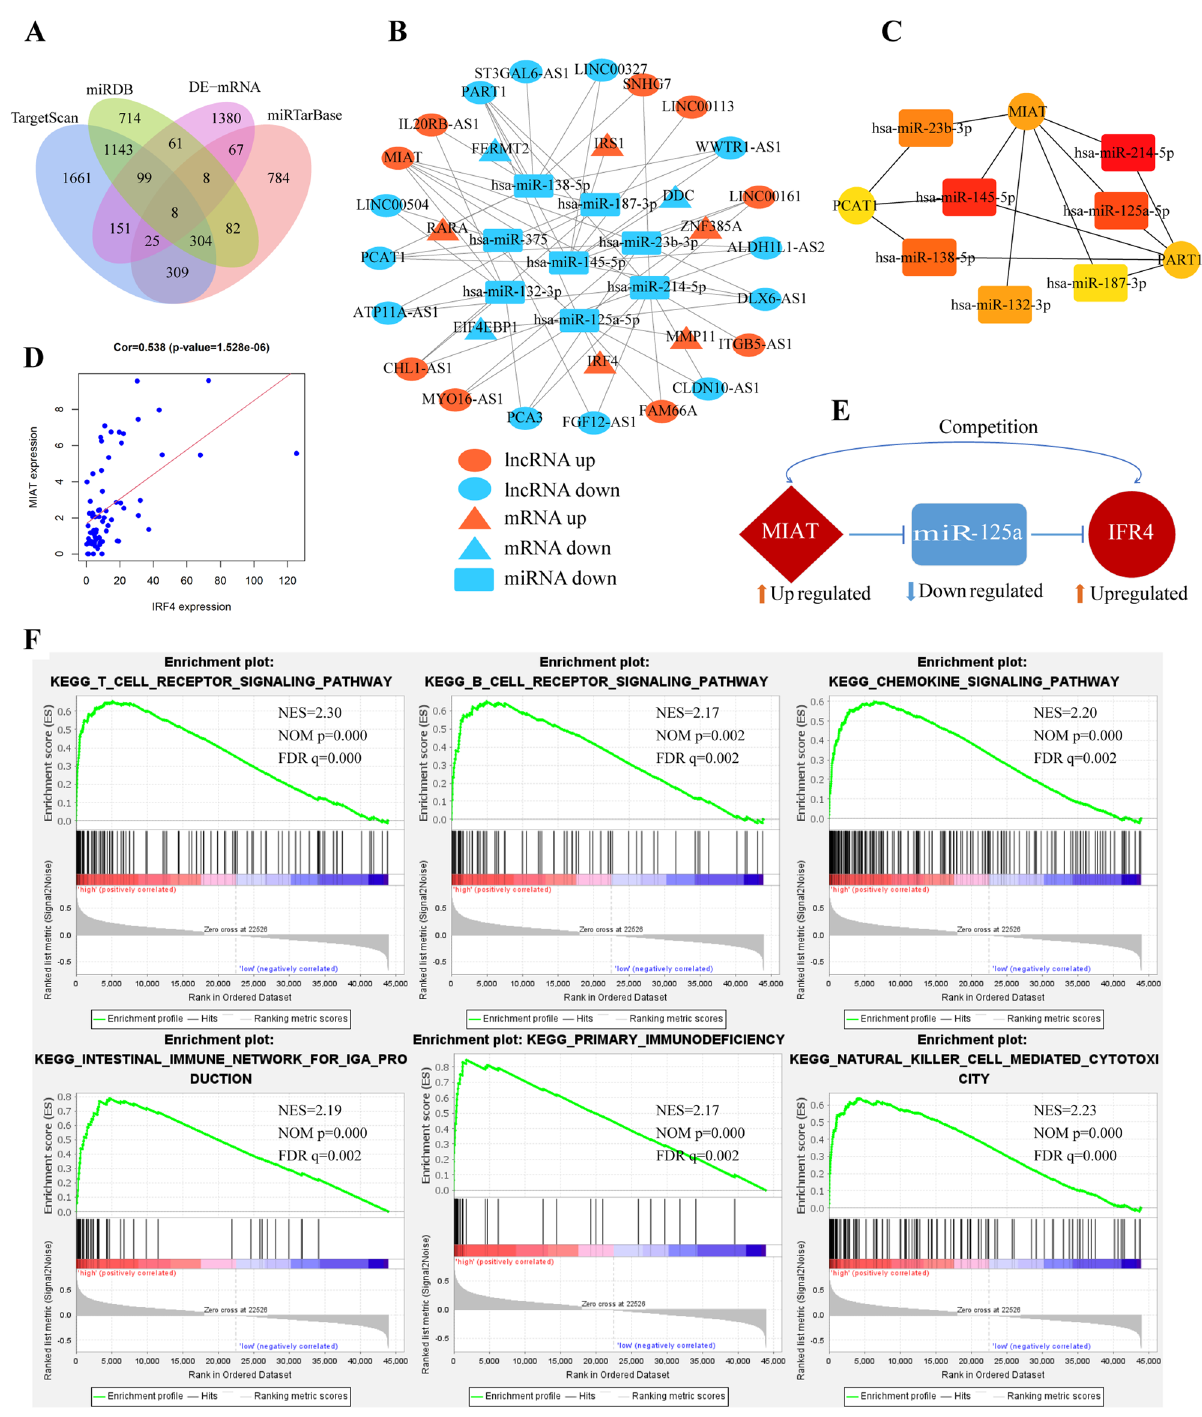
Figure 4. A potential lncRNA-miRNA-mRNA ceRNA network was constructed. ( A ) Venn diagram of predicted target mRNAs and DE-mRNAs. ( B ) The ceRNA network derived from DEGs in CRSwNP. The ellipses, round rectangles and triangles represent lncRNAs, miRNAs and mRNAs, respectively. Upregulation is represented by red nodes, while downregulation is represented by blue nodes. ( C ) Ten hub genes in this network using the Cytoscape plug-in cytoHubba. ( D ) Correlation analysis between MIAT and IRF4 in CRSwNP. ( E ) The MIAT/miR-125a/IRF4 regulatory axis perfectly conformed to the ceRNA hypothesis. ( F ) Gene set enrichment analysis of IRF4. DE-mRNA, differentially expressed mRNA; NES, normalized NS; FDR, false discovery